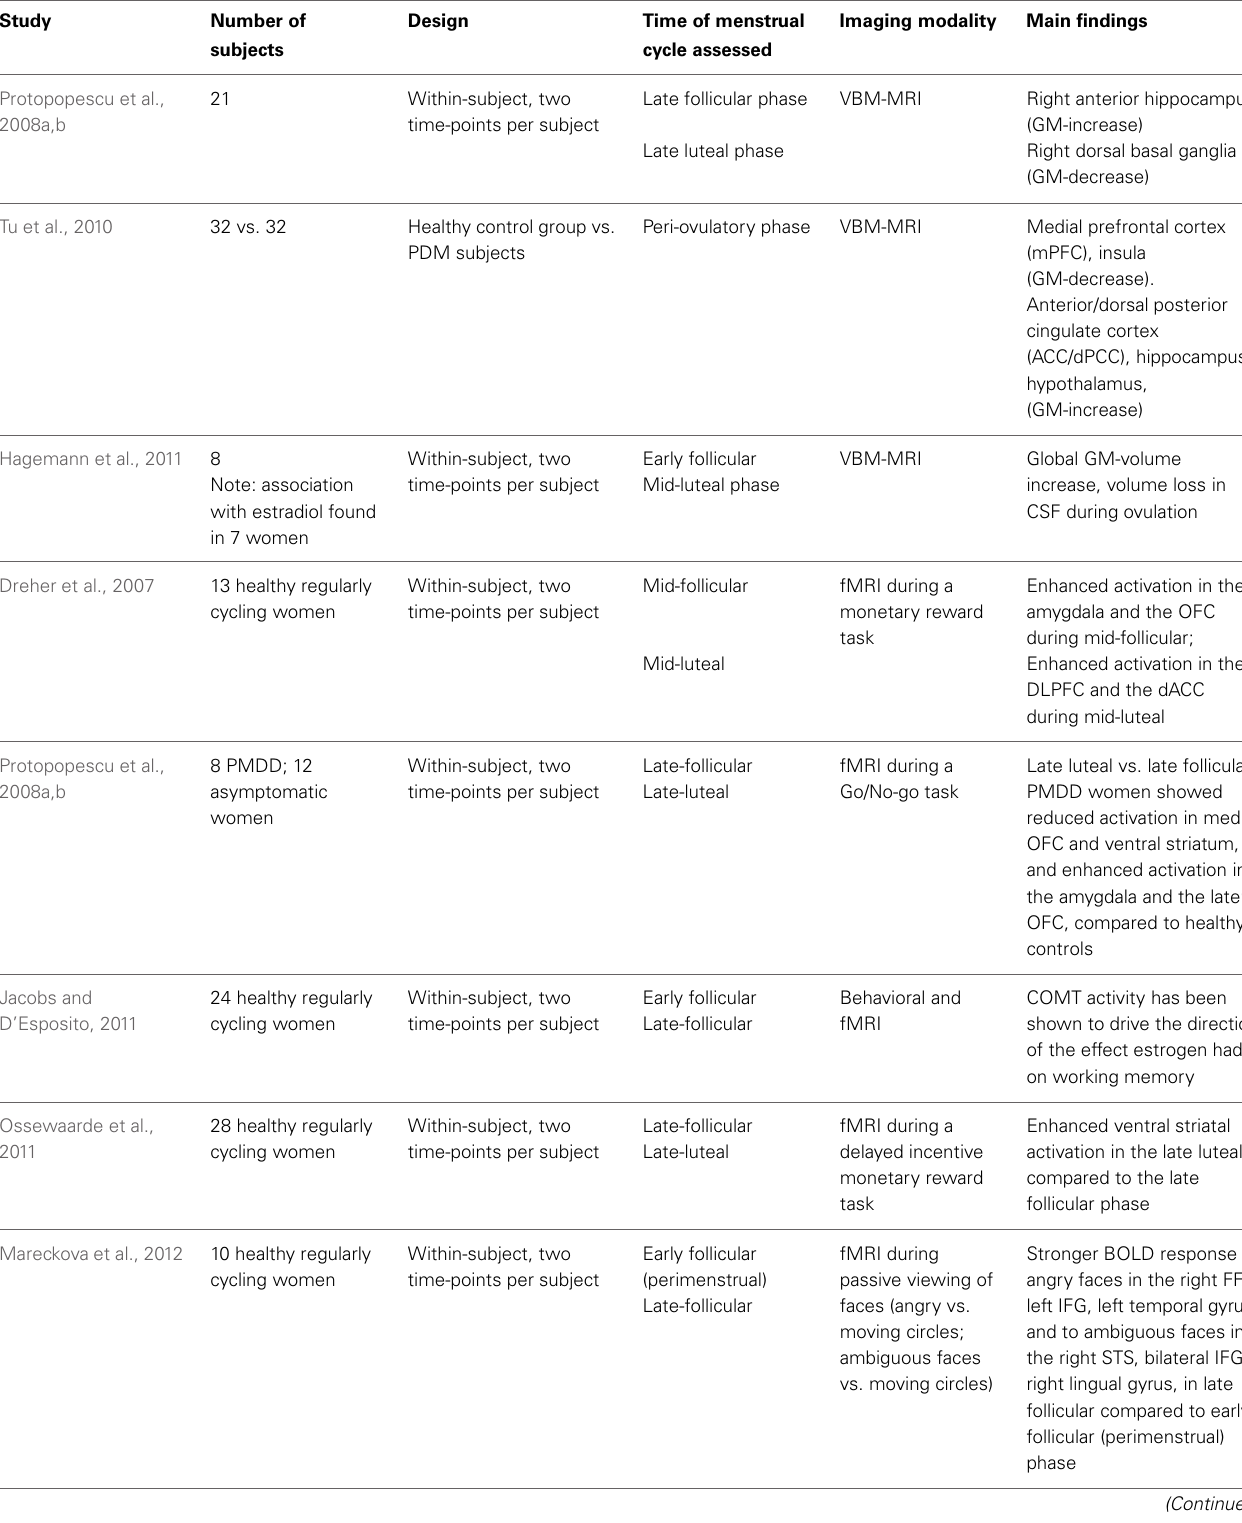
Table 1 | Summary of imaging studies exploring the impact of the menstrual cycle on neuroplastic changes of relevance to the interplay of emotion and